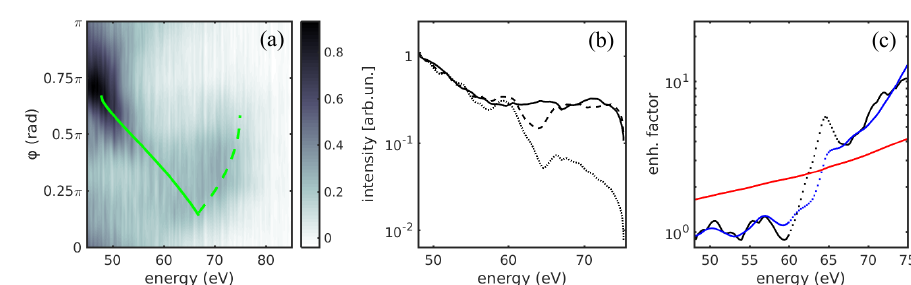
Fig 1. (a) HHG spectra in Xe as a function of φ, green line indicates the position of the upper (dashed line) and lower (solid line) caustic for a limited range of φ values. (b) Yield at the caustic: experiment (solid line), full-TDCIS (dashed line), 5p z -TDCIS (dotted line). (c) Enhancement factor: ratio of experimental and 5p z -TDCIS yields (black line), ratio of full-TDCIS and 5p z -TDCIS yields (blue line), ratio of full-PICS and 5p z -PICS (red line). Dotted curves indicate a region where a single recombination event cannot be efficiently isolated. PICS taken from ref.